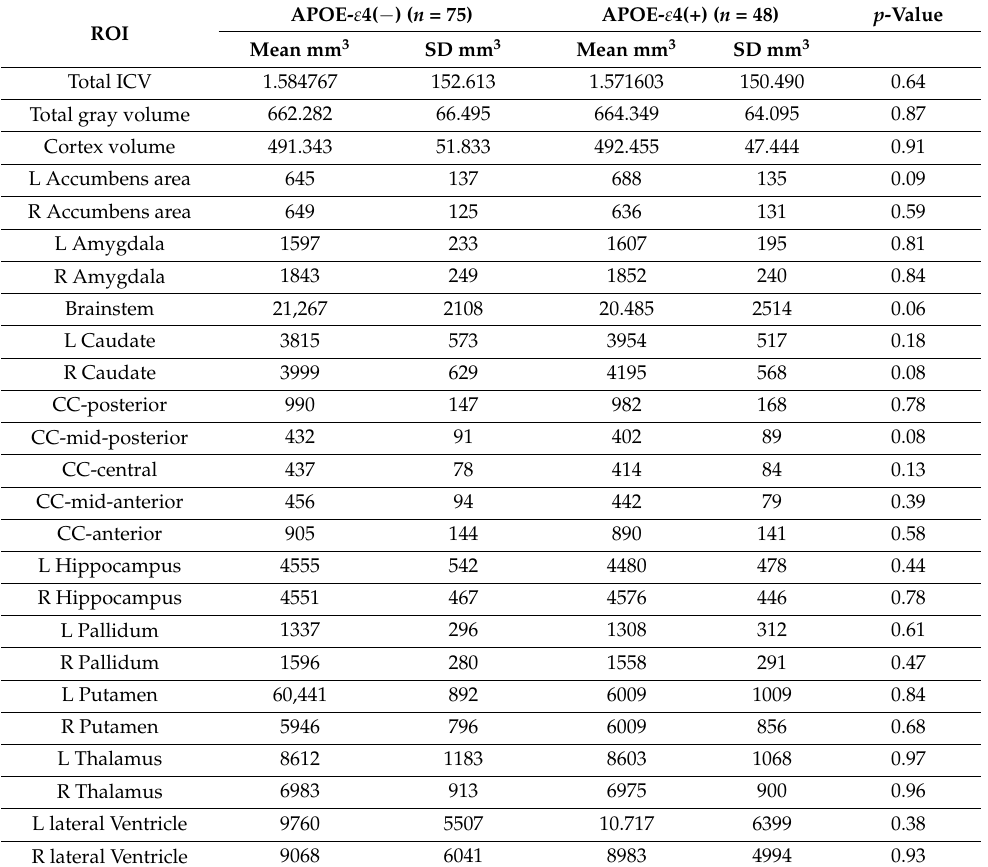
Table 5. APOE ε 4 status on mean values of neuroanatomic volume measurements per region of interest (ROI).